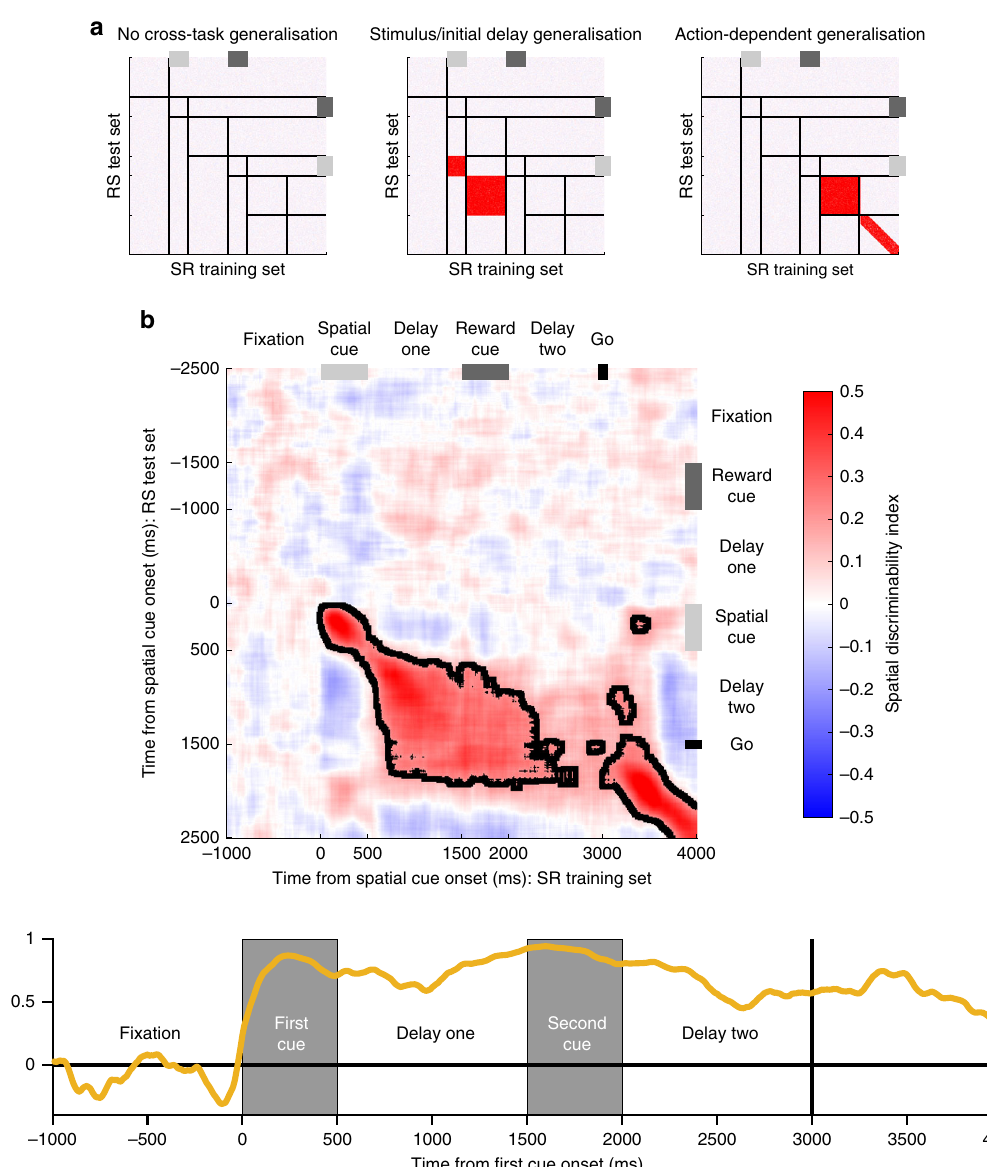
Fig. 6 Cross-generalisation of working memory activity across-trial types. By using data from SR-trials as a training set for a classi fi er, and data from RS- trials as a test set, the generalisability of spatial coding across task types can be studied. a Exemplars of how population activity may generalise across-trial types. If there is no cross-task generalisation, spatial position cannot be decoded from neural activity on the other trial type. As VLPFC has spatial coding on both trial types (Fig. 2), if there is no cross-task generalisation this would mean there are multiple network patterns of spatial selectivity capable of supporting correct performance. If there is stimulus-locked generalisation, spatial position can be decoded by activity from the other trial type; however, it